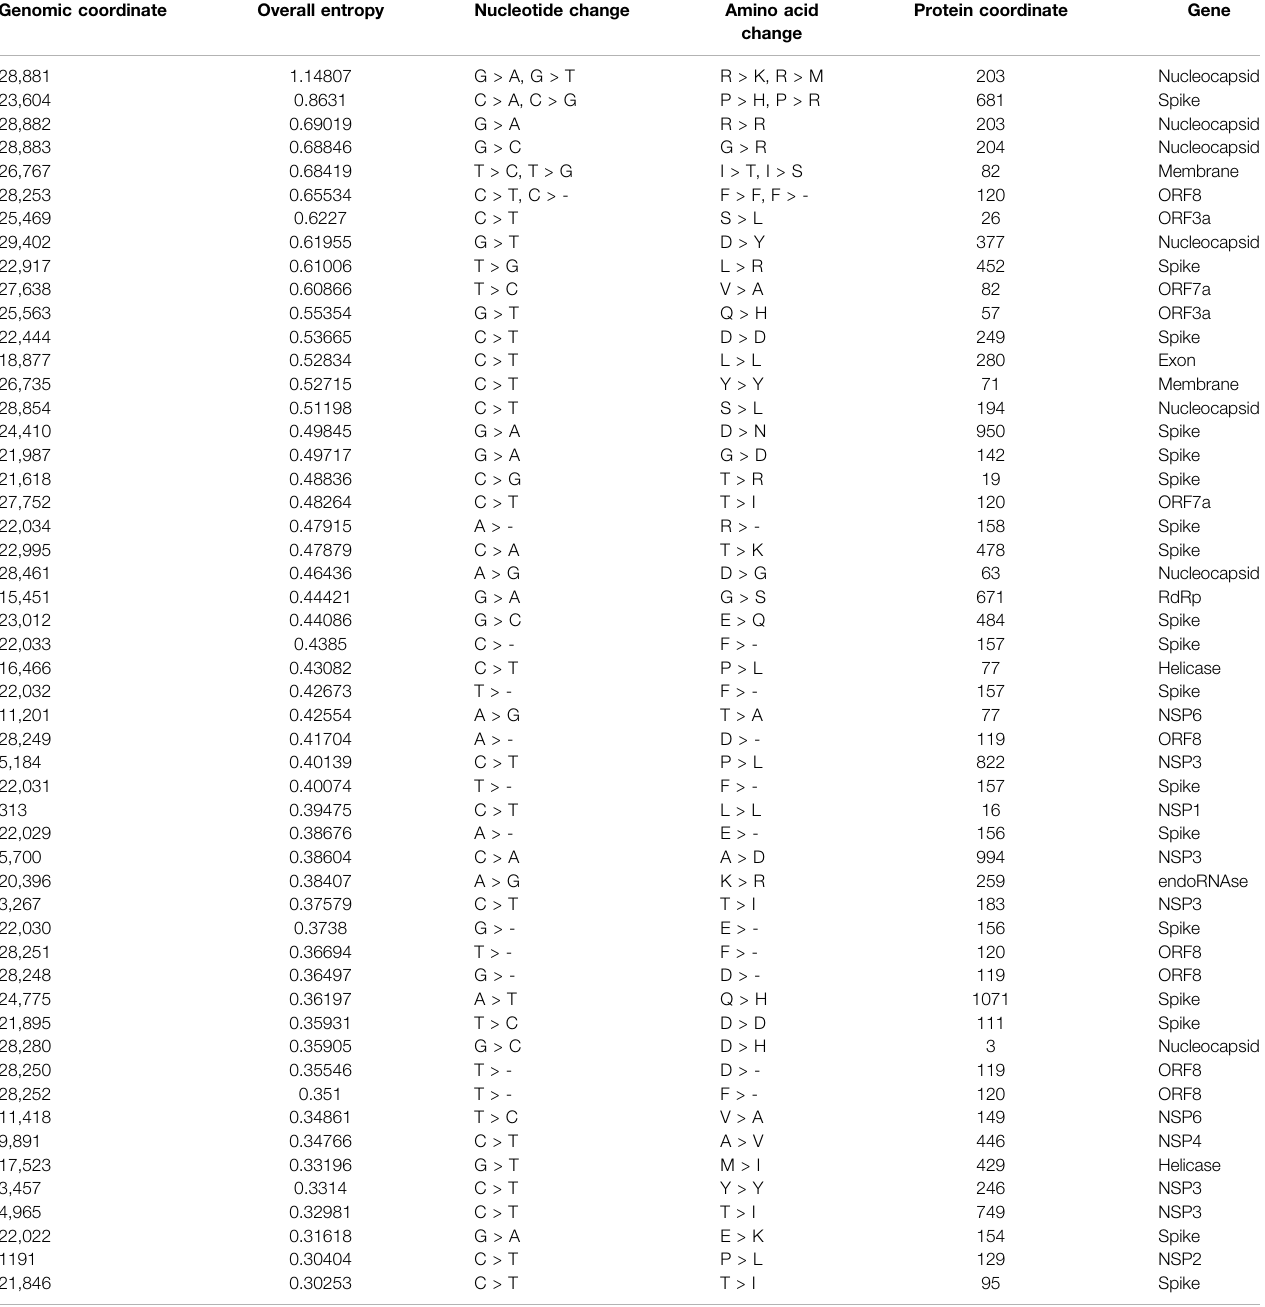
TABLE 3 | List of hotspot mutations for 10,286 Indian SARS-CoV-2 genomes along with the protein change. Genomic coordinate Overall entropy Nucleotide change Amino acid